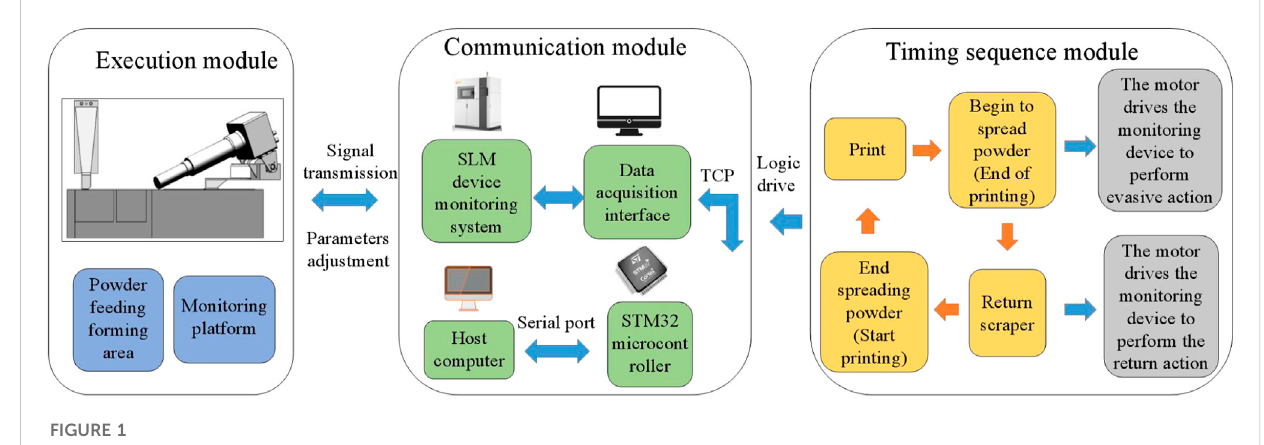
FIGURE 1 Framework of the whole control